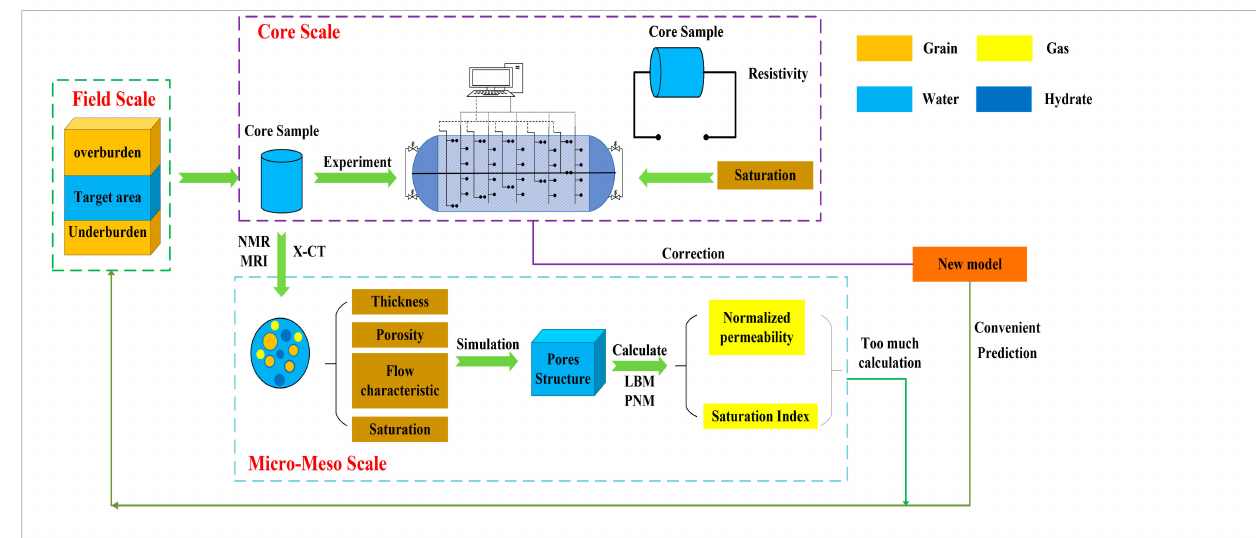
Figure 8. Field-scale permeability simulation based on combined micro-macro